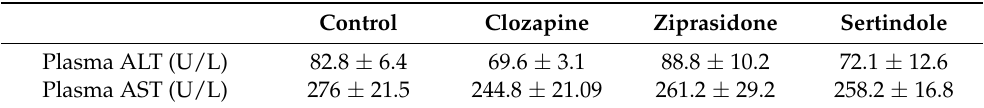
Table 1. The alanine aminotransferase (ALT) and aspartate aminotransferase (AST) activities (U/L) in rats after treatment with clozapine, ziprasidone and sertindole.